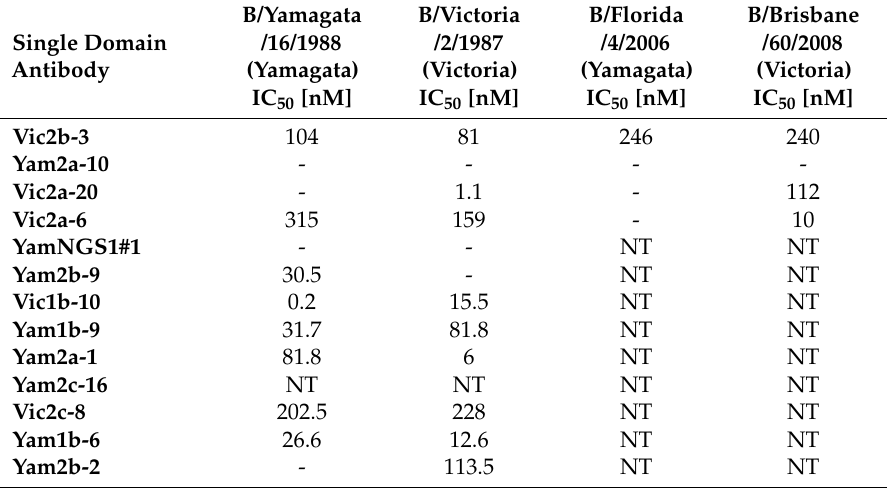
Table 4. Neutralisation of the influenza B pseudotype